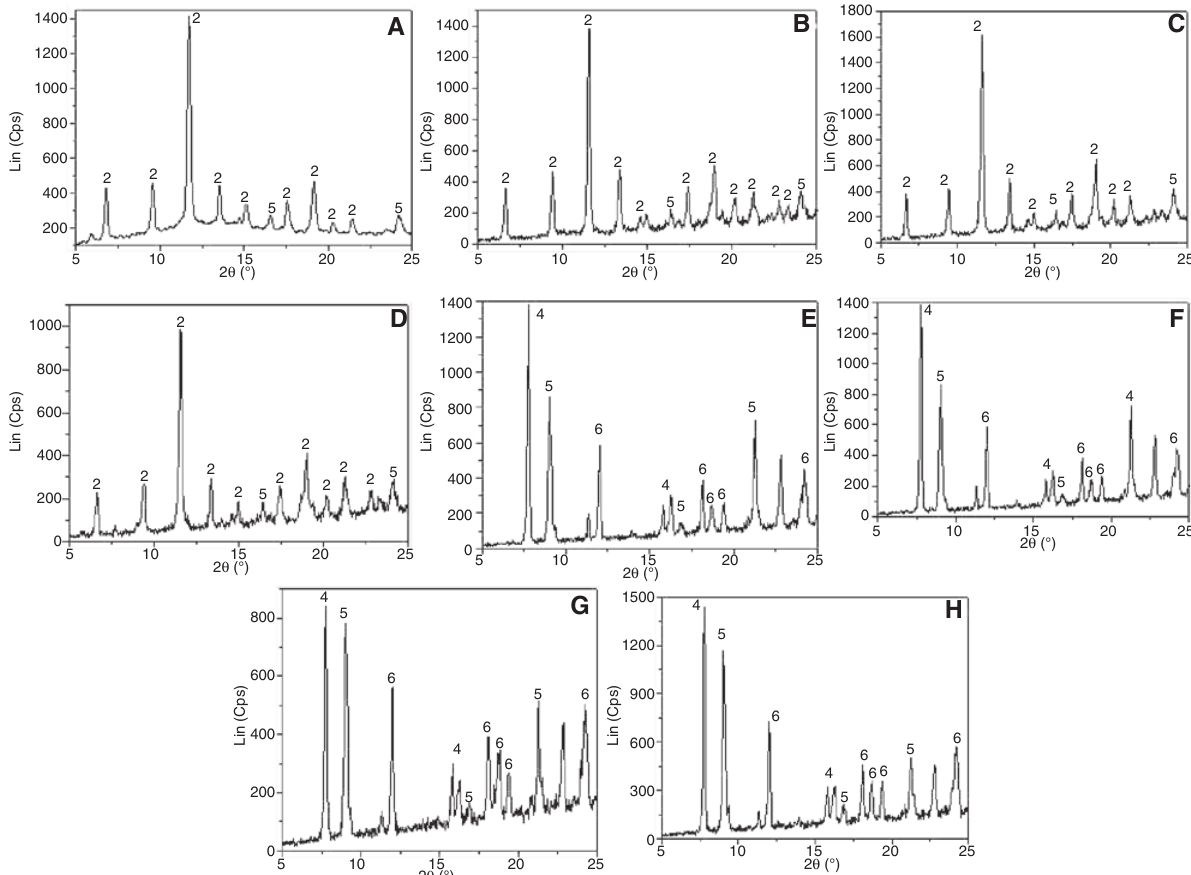
H CuO ; 4-C H CuO ·3H O; 5-C H Cu; 3 5 2 8 4 4 2 6 5